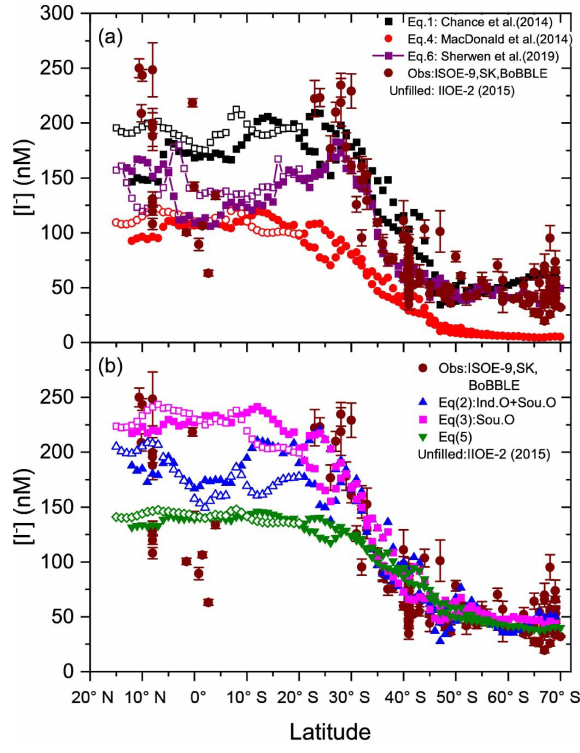
Figure 3. Latitudinal averages of calculated sea surface iodide (SSI) concentrations for each campaign using (a) existing and (b) new parameterisation tools and observations from ISOE-9, SK-333, and BoBBLE. Filled markers represent combined SSI from ISOE-8 and ISOE-9; unfilled markers represent SSI from the IIOE-2